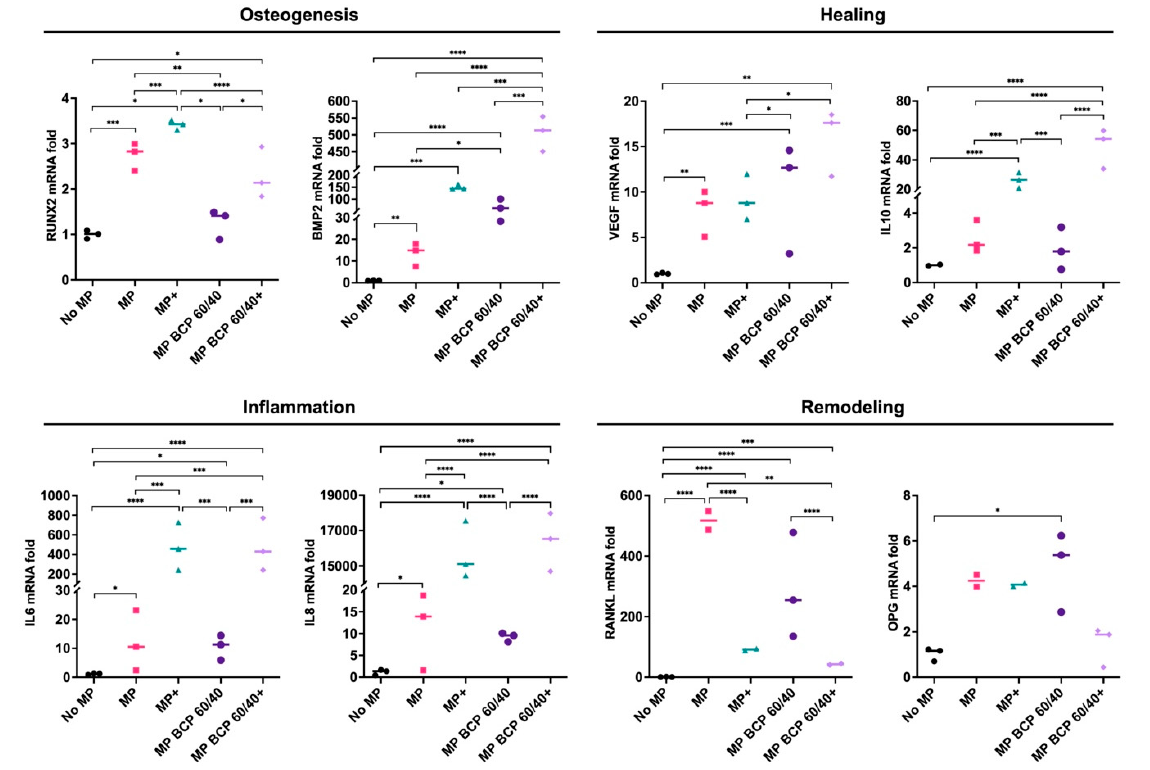
Figure 5. Relative mRNA expressions (fold changes) of osteogenesis-, healing-, inflammation- and remodeling-related genes in MSCs cultured with BCP 60/40 and/or MPs (n = 3). No MP, monolayer MSC control; MP, monolayer MSCs cocultured with MPs; + represents cytokine stimulation. Statistical analyses are based on one-way ANOVA with Tukey’s multiple comparison tests on delta-Ct values; * p < 0.05; ** p < 0.001; *** p = 0.0001; **** p < 0.0001.